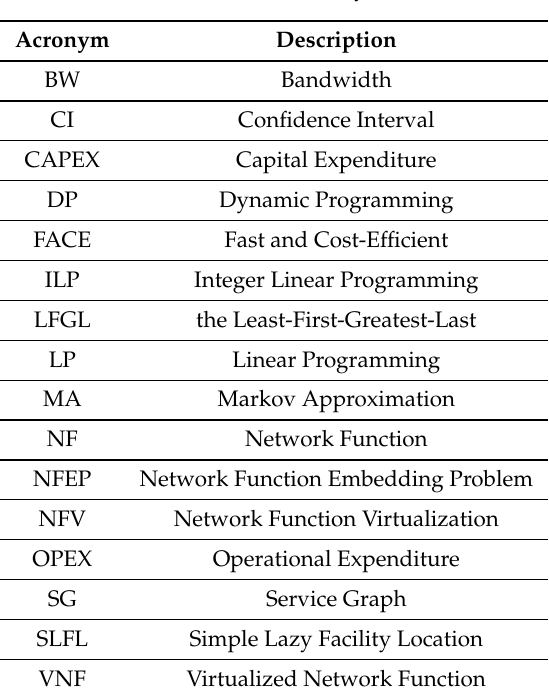
Table 1. List of